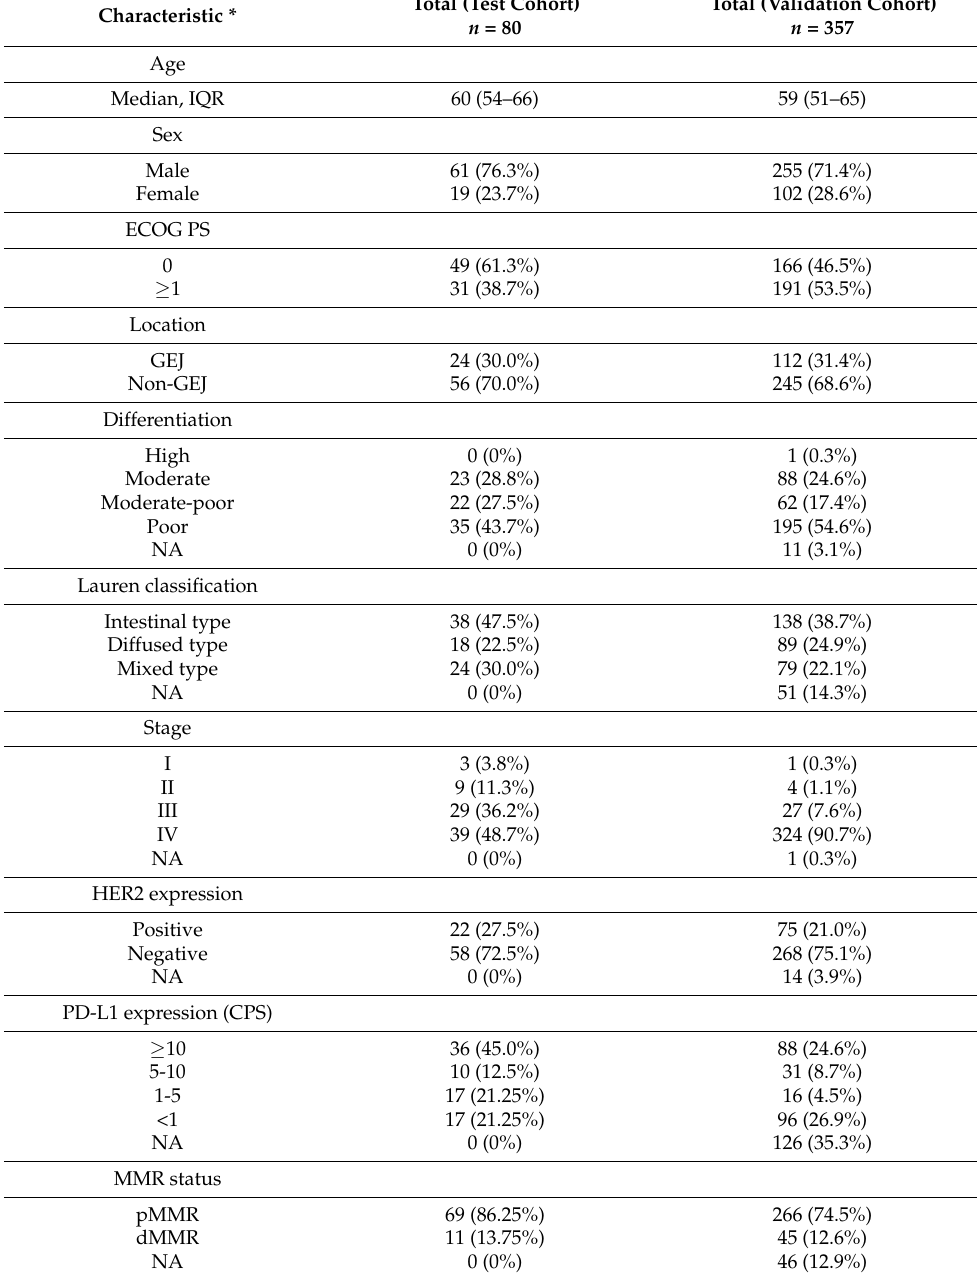
Table 1. Baseline characteristics of gastric cancer